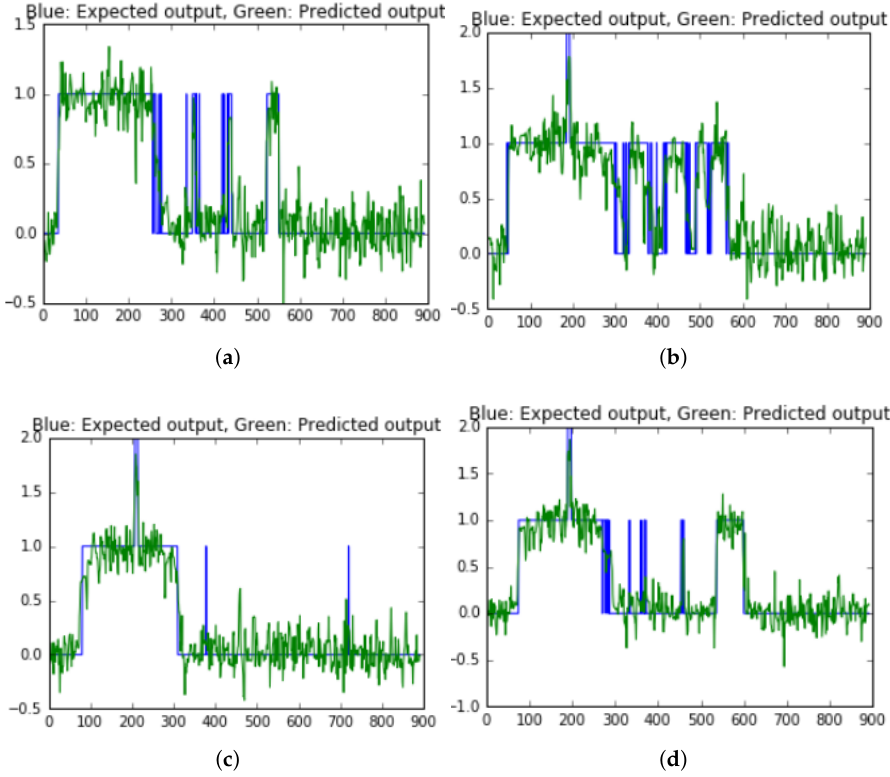
Figure 16. Classification results of LSTM model on test 1 to test 4 data: ( a ) Test 1; ( b ) Test 2; ( c ) Test 3; ( d ) Test 4.